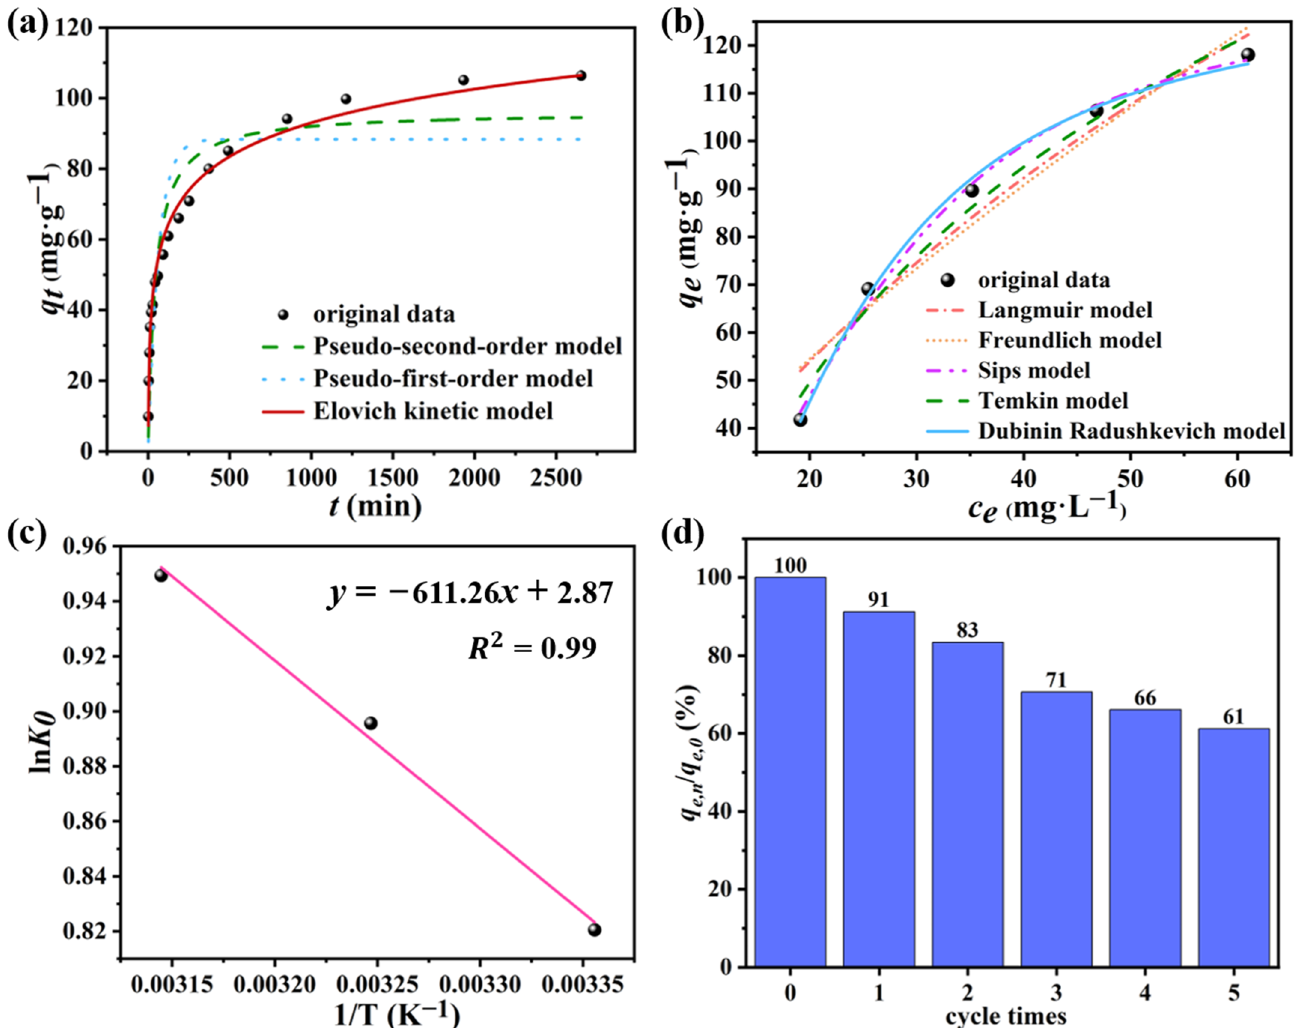
Figure 6. Adsorption kinetic model fitting ( a ); Adsorption isotherm fitting ( b ); Fitting results of thermodynamic calculation ( c ); Regeneration performance ( d ).